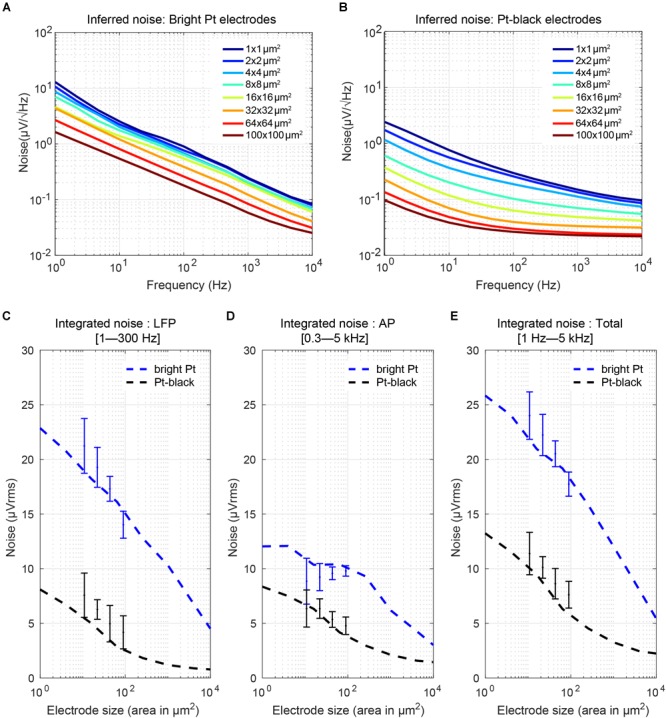
Electrode noise: (A,B) Noise power spectral density (PSD) of Pt-electrodes and Pt-black electrodes computed from the real part of the measured electrode impedance. The electrodes show 1/f noise characteristics at low frequencies and reach a plateau of thermal noise at higher frequencies. After Pt-black deposition, the noise spectral density was significantly reduced and reached a plateau defined by the spreading resistance (which depends on the electrode geometric area and solution resistance). (C–E) Integrated noise (μVrms) of the electrodes in the AP region, LFP region, and over the full bandwidth (1 Hz to 5 kHz) versus electrode size and comparison to measurement results obtained with four electrode sizes (el1: 86 μm2; el2: 44 μm2; el3: 22 μm2; el4: 11 μm2) on an HD-MEA. For bright Pt electrodes, the noise in the LFP band increased from 5 μVrms to 23 μVrms for going from a 100 × 100 μm2 size electrode to a 1 × 1 μm2 size electrode. In the AP band, the noise increase was less, only from 3 μVrms to 13 μVrms. After Pt-black deposition, the LFP noise and AP noise was below 8 μVrms for all electrode sizes.